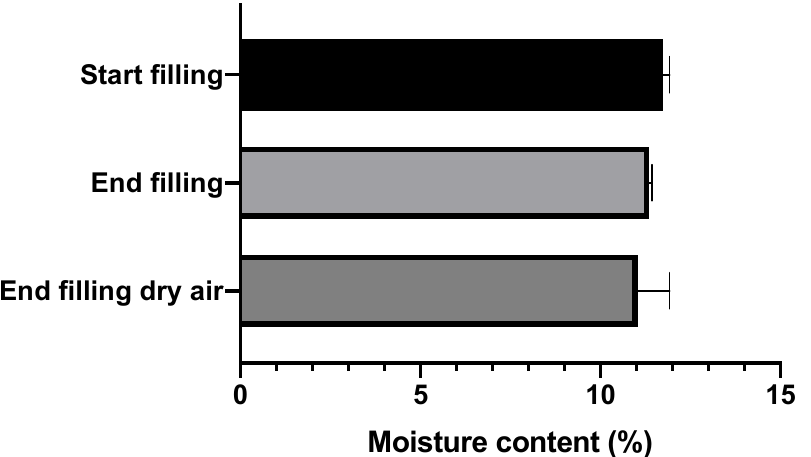
Figure 3. The moisture contents for the amikacin formulation automatically filled into SDCs. Start filling samples are the first five SDCs filled under normal conditions. End filling samples are the last five SDCs filled under normal conditions. The end filling dry air samples are the last five SDCs filled when automatic filling took place under dry air (average ± SD, n = 10).